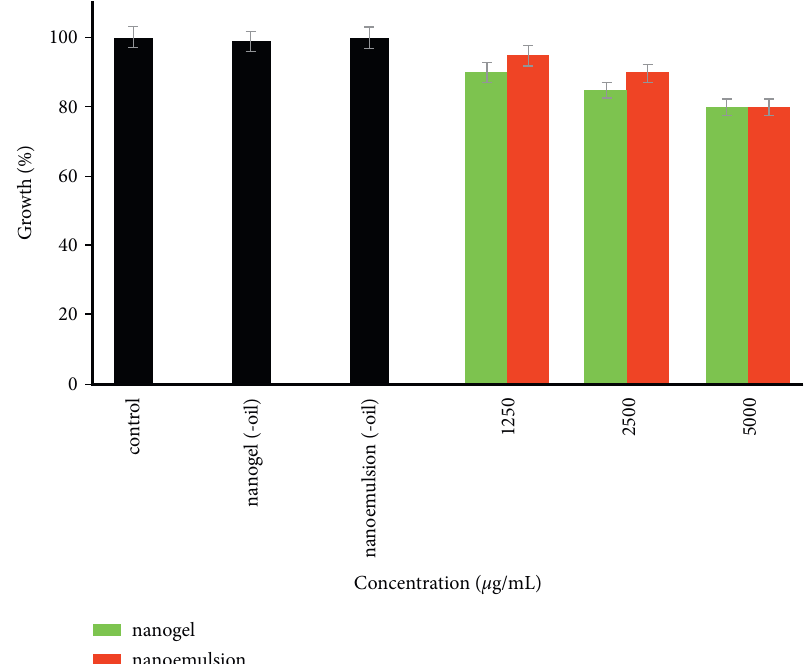
Figure 4: Antibacterial activity of EGEO-nanogel and EGEO-nanoemulsion against P. aeruginosa .